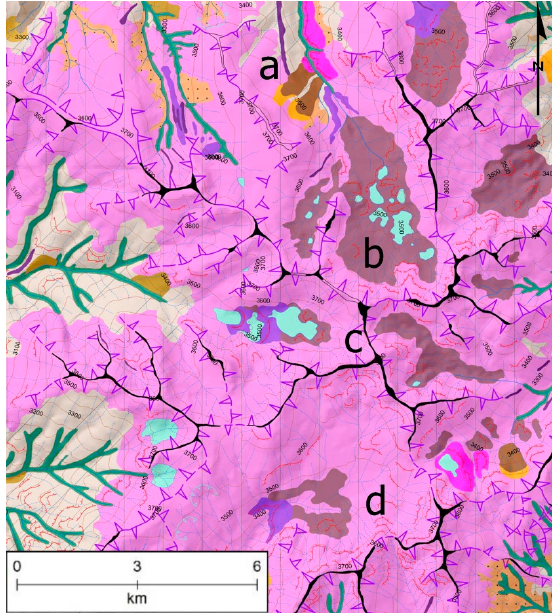
Figure 5. Digital glacial geomorphology of Costa Rica’s top summits, which were glacially modeled during the LGM. ( a ) Lateral moraine, ( b ) till deposits, ( c ) arêtes, ( d ) periglacial dynamics. More details and locations can be seen in Quesada-Román et al. [68] and Quesada-Román and Zamorano [69].